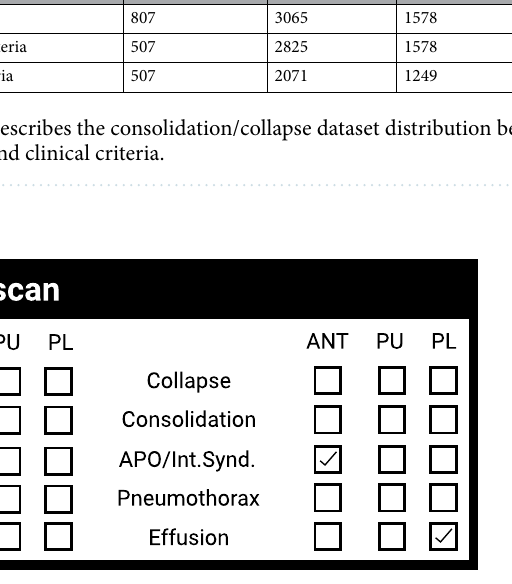
Figure 4. Example of the information provided by the medical report where each LUS scanning region consists of a video that has been checked marked if it contains a